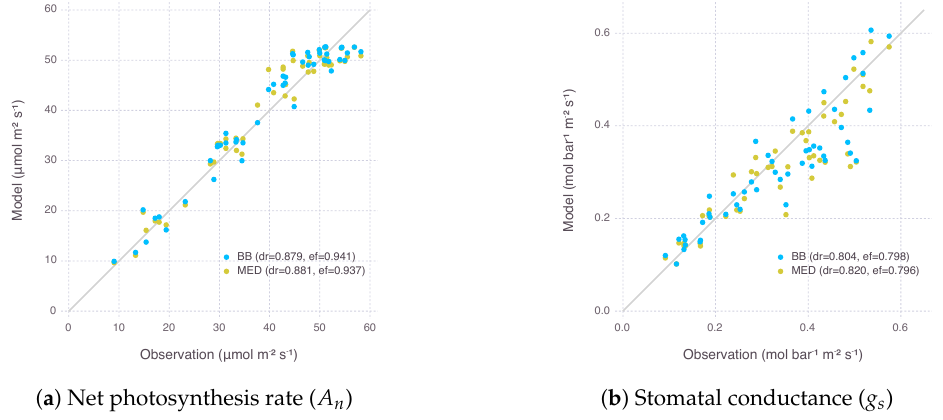
Figure 1. Evaluation of the gas-exchange model with two stomatal conductance submodels, Ball–Berry (BB) and Medlyn (MED), after calibrating parameters related to nitrogen ( N 0 , s ) and stomata ( g 0 , g 1 ). Each dot represents an observed photosynthesis rate ( A n ) or stomatal conductance ( g s ) under a given experimental condition and a corresponding estimation by the model. A gray solid line shows 1:1 reference for comparison. dr indicates Willmott’s refined index of agreement ( d r ), and ef indicates Nash–Sutcliffe modeling efficiency coefficient